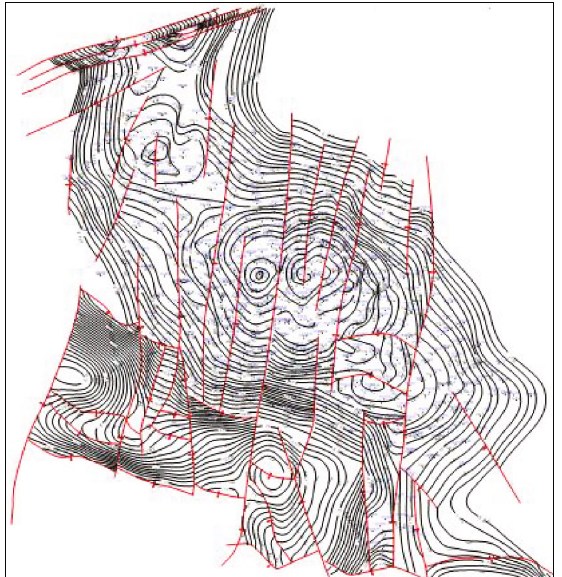
Figure 4: The structure of the study area.